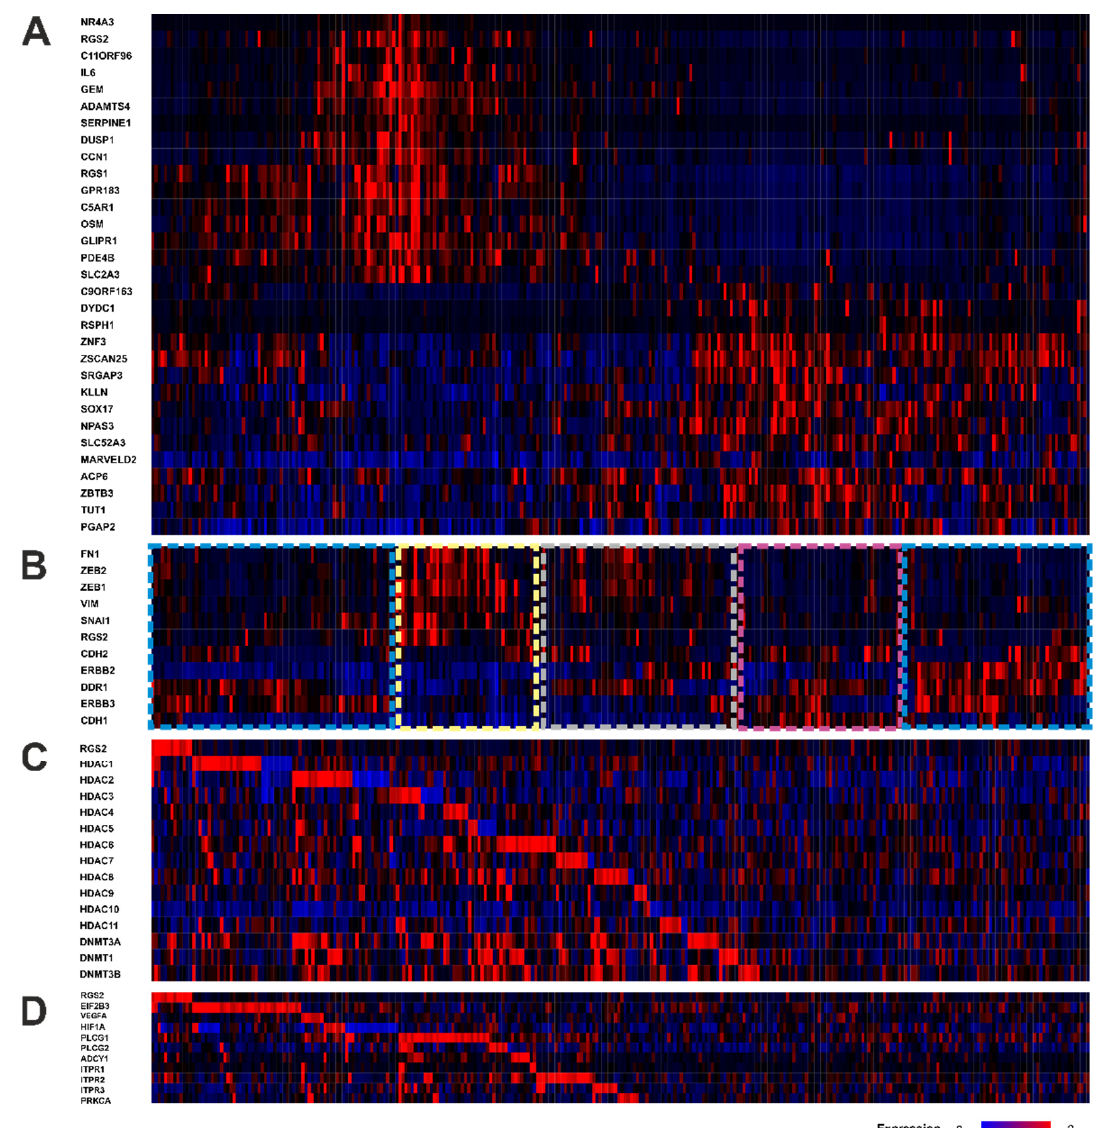
Figure 4. Bulk mRNA expression data from the TCGA HGSOC cohort ( n = 299) for functional relevant genes in the context of RGS2 expression obtained from cBioportal. ( A ) Differential expression of the TOP15 genes with strongest and weakest co-expression with RGS2. RGS2 shows moderate co-expression of genes associated with signaling or pro-inflammatory states and negative correla- tion with genes coding for zinc finger domains. ( B ) RGS2 and co-expression of maker genes for epithelial-mesenchymal transition (EMT) reveals four different clusters: I. RGS2 barely detectable, downregulation of classical EMT hallmark genes and upregulation of alternative genes for EMT (blue boxes on the left and right), II. H-RGS and upregulation of EMT hallmark genes (yellow box), III. L-RGS and downregulation of EMT hallmark genes (grey box), IV. RGS2 barely detectable and variable regulation of both classical and alternative EMT hallmark genes (pink box). ( C ) RGS2 and co-expression marker genes for methylation reveals increased methylation activity more than 50% of patients with low RGS2 expression. ( D ) RGS2 and co-expression of genes associated with RGS2 downstream signaling, hypoxic cell stress and alternative signaling mechanisms demonstrates post-translational modification (EIF2B3), hypoxic cell stress (HIF α ) and compensatory upregulation of downstream targets in nearly half of the patients with low RGS2 expression and underlines the positive feedback loop between RGS2 suppression and phospholipase C (PLCG1 and 2) mediated phosphorylation of RGS2.